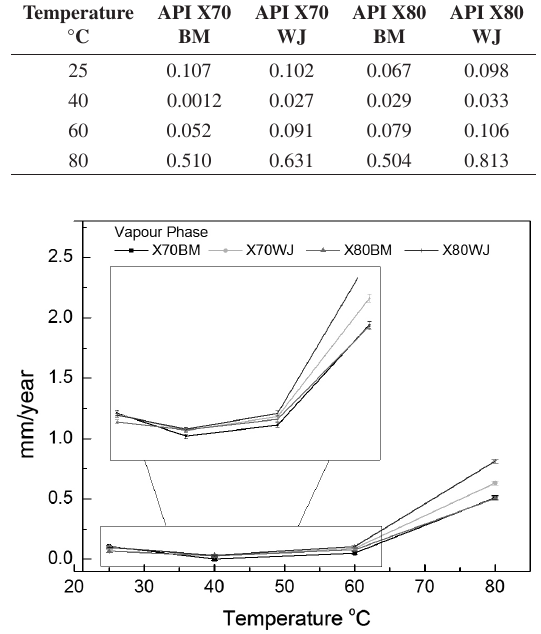
Figure 6. Corrosion rate of the fully immersed samples. Figure 7. Corrosion rate of the vapour